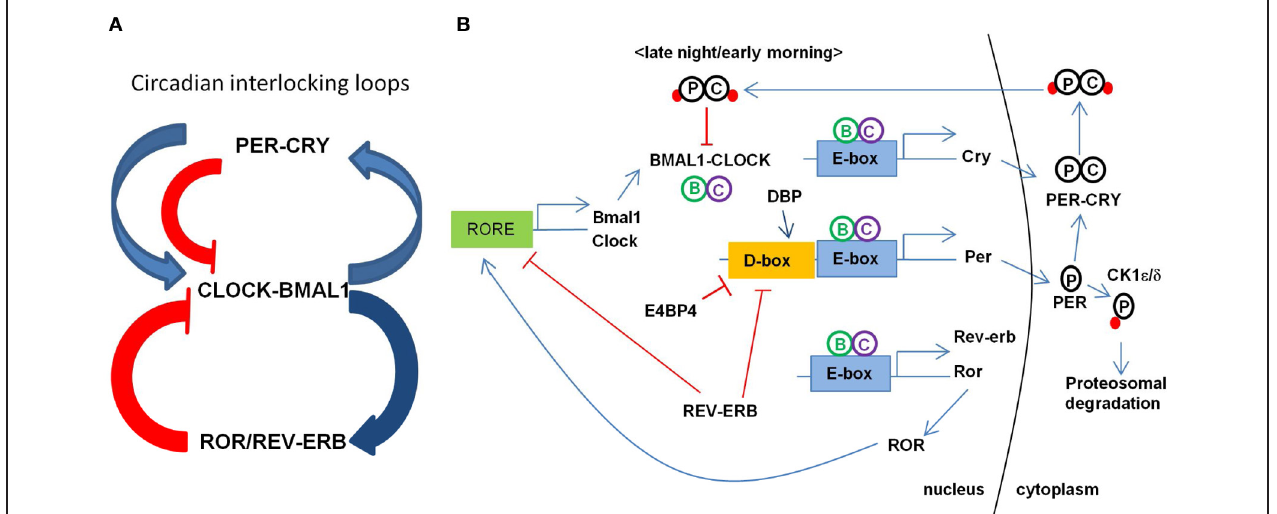
and CLOCK is regulated by ROR and REV-ERB through binding RORE elements at their promoters. CLOCK and BMAL1 activates the expression of CRY, PER, REV-ERB, ROR, and other CCGs (clock controlled genes) through binding to E-box element at their promoters. CRY-PER complex is phosphorylated and transported back to the nucleus inhibiting the CLOCK-BMAL1 activity. PER is phosphorylated to degrade through proteosomal pathway via CK1 ε / δ